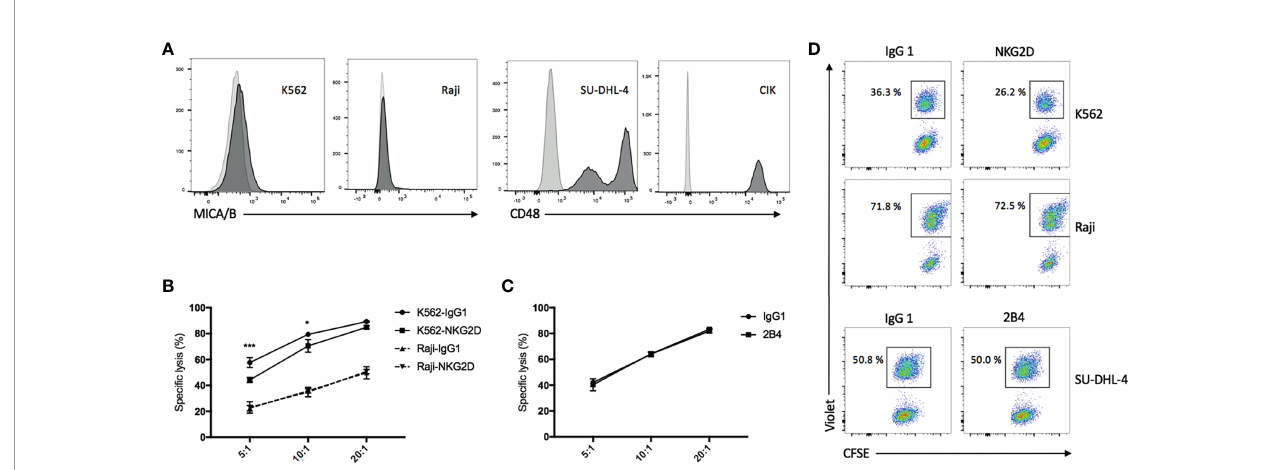
FIGURE 2 | Blockade of NKG2D but not 2B4 attenuates the CIK cell-mediated cytotoxicity and E/T conjugate formation. (A) FACS histograms demonstrating the presence of MICA/B on K562 cells and absence on Raji cells (left) and the presence of CD48 on all SU-DHL-4 cells and CIK cells (right). (B) Blocking cytotoxicity was performed by preincubation of CIK cells with IgG1 isotype control or anti-NKG2D (clone 1D11) antibodies (10 µg/ml) for 30 min prior to coculture with CFSE- labeled K562 or Raji cells. After 6 – 8 h of coculture at indicated effector/target (E/T) ratios, cells were stained with viability dye Hoechst 33258 and measured on fl ow cytometry. (C) Cytotoxicity was performed as described in “ B ” by preincubation of CIK cells with IgG1 control or anti-2B4 (clone C1.7) antibodies (10 µg/ml) for 30 min prior to coculture with CFSE-labeled SU-DHL-4 cells at indicated E/T ratios. (D) CellTrace Violet-labeled CIK cells were preincubated with IgG1 control or anti- NKG2D or anti-2B4 antibodies (10 µg/ml) for 30 min and then cocultured with CFSE-labeled K562 (top panel) or Raji (middle panel) or SU-DHL-4 cells (bottom panel) at a 5:1 E/T ratio in the presence of 7AAD for 10 min at 37°C. As next, cells were fi xed with 1% paraformaldehyde and measured on fl ow cytometry. CFSE+Violet+ double-positive events were considered the E/T conjugate. Plots show the percentage of E/T conjugate within the CFSE+ target gate. Aforementioned data are shown as mean ± SD of triplicates per condition and one representative of three independent experiments. * p < 0.05, *** p < 0.001 calculated by two-way ANOVA, Bonferroni ’ s post-hoc